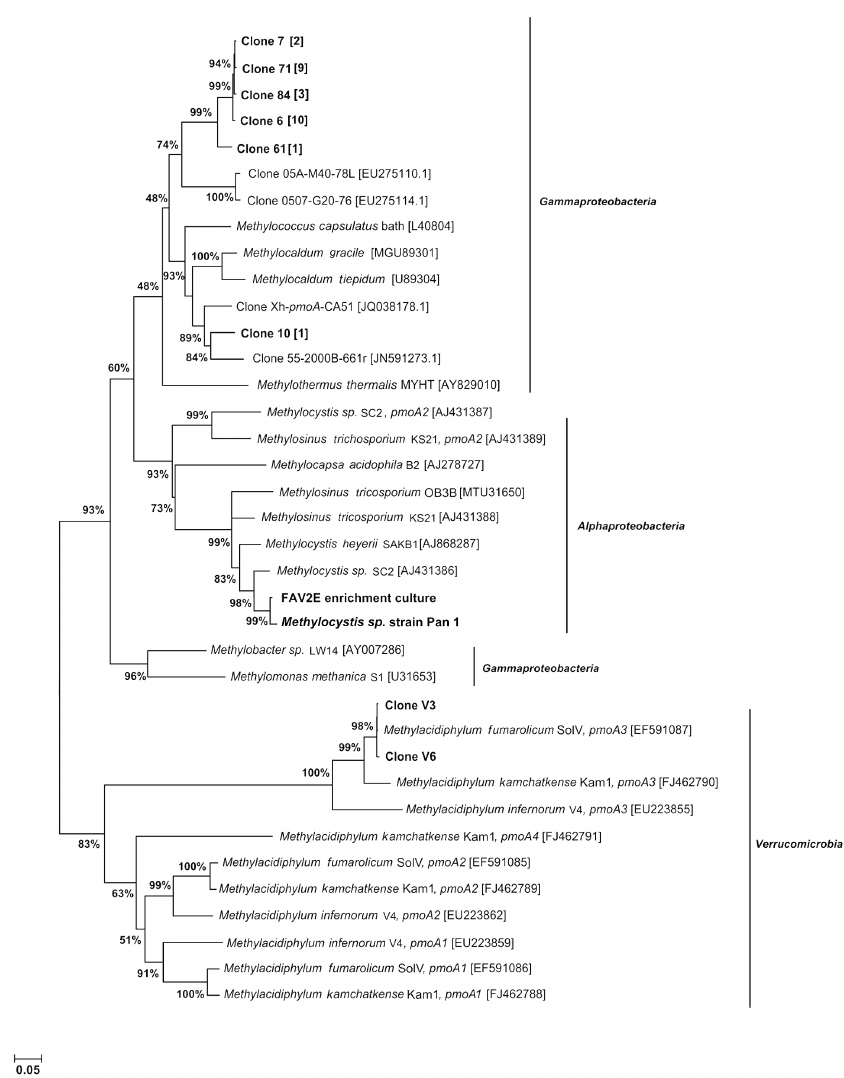
Figure 3. Phylogenetic tree constructed based on partial sequences (529nt) of pmoA genes, showing the relative position of the genes and isolates from the FAV2 geothermal site where high methane oxidation rates were detected. The tree was constructed in the Molecular Evolutionary Genetics Analysis (MEGA) software version 4.0 (Tamura et al., 2007), and a maximum composite likelihood (MCL) model was used ( Schmidt et al., 2002). A neighbour-joining distance correction method was applied. Node support values are indicated for the primary nodes. The scale bar represents a 0.05 change per position. FAV2E enrichment culture derives from amplification of the final stage of the enrichment; all the others are from the FAV2 soil clone library. Pan1 was isolated from the enrichment cultures, together with Pan2 and Pan3 (not shown); the total number of clones with identical sequences is indicated in square